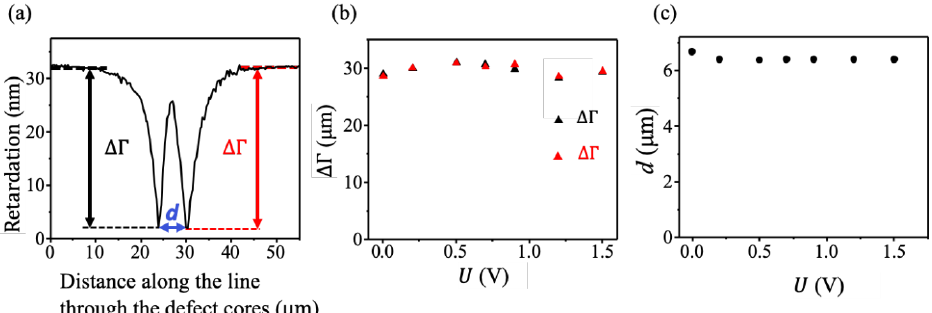
Figure 3. ( a ) Retardation Γ along a line passes through the core of a +1 radial defect. The two minima relate to two +1/2 defect cores. ∆Γ is the change of retardation between the defect core and the far field. ( b ) The change ∆Γ of retardation as a function of voltage, U. ( c ) The separation distance between two defect cores, d as a function of voltage, U. The data is collected from a cell photopatterned 2 h with radial ± 1 defect array. The cell thickness is 1.15 µ m. The separation distance 𝑑 between the ± ½ defect cores was measured as the dis- tance between the minima in the optical retardance maps, Figure 3a, and the polarizing optical microscopy (POM) images of the patterns, Figures 2b,c and 4. The POM images were analyzed using the open-source software package Fiji/ImageJ. The distance d was calculated by averaging the data measured for all 50 defects of the same sign in the array. The error 𝛿𝑑 for d value was calculated as the standard deviation [42].